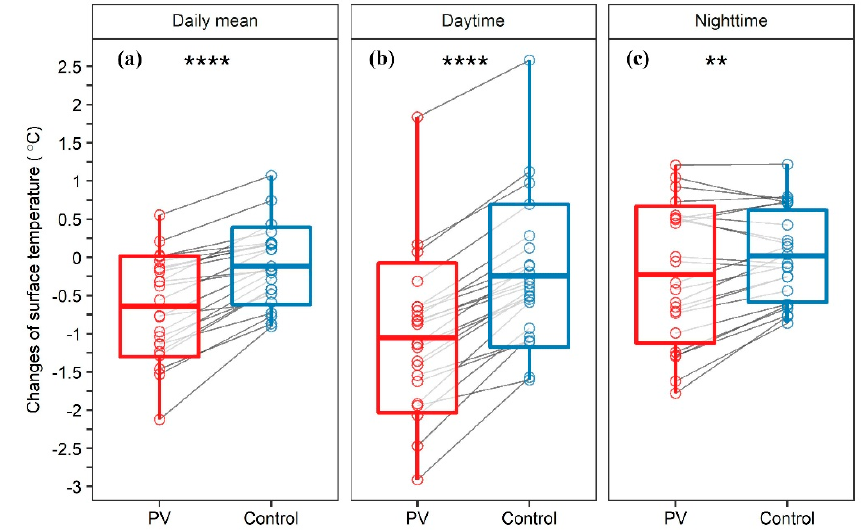
Figure 2. The yearly average surface temperature changes in the PV powerplants (blue part) and the 2 km buffer zones (red part), separated into ( a ) daily mean, ( b ) daytime, and ( c ) nighttime. The boxplot is composed of the mean (solid line), the lower and upper standard deviation bounds (box), the maximum and minimum (whiskers). The Paired t-test was used to determine the difference of the two groups, the gray line connected the paired points; ns, *, **, *** and ****: statistically significant at p > 0.05, p < 0.05, p < 0.01, p < 0.001, and p < 0.0001 levels.